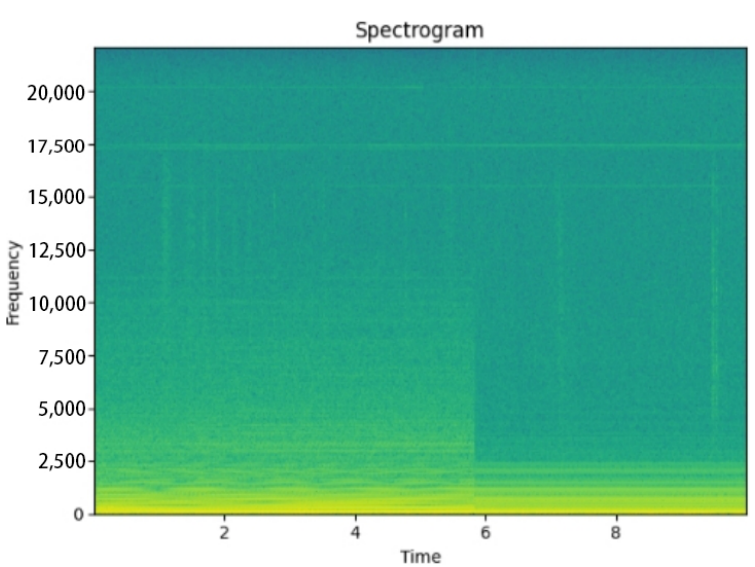
Figure 5. Discharge transformer spectrogram.